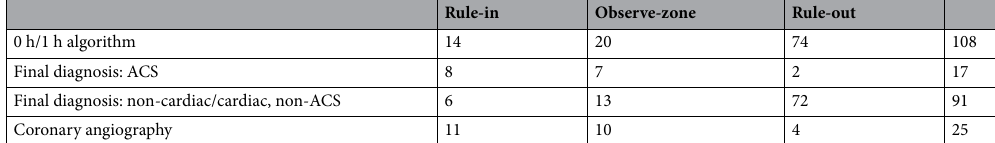
Table 4. Patient classification according to 0 h/1 h algorithm after 1 h with number of patients who underwent coronary angiography. ACS acute coronary syndrome, hscTnT high-sensitive cardiac troponin T.